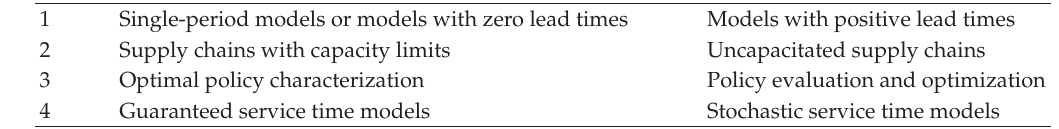
Table 1: Classification of the